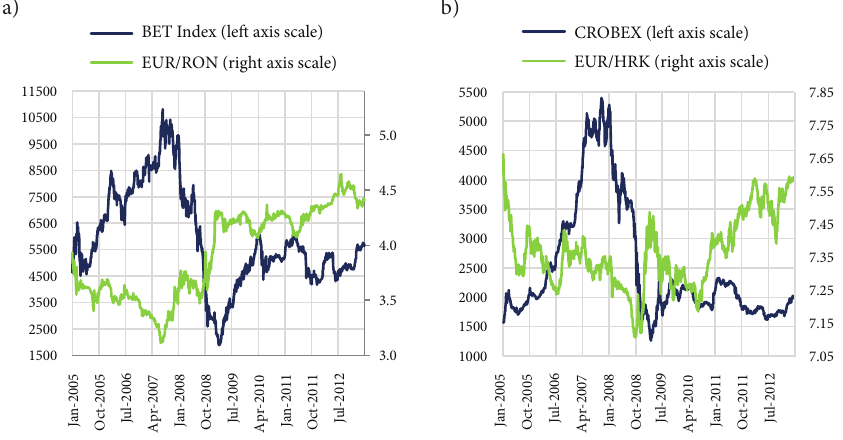
Fig. 1. BET Index vs. EUR/RON (a); CROBEX Index vs. EUR/HRK